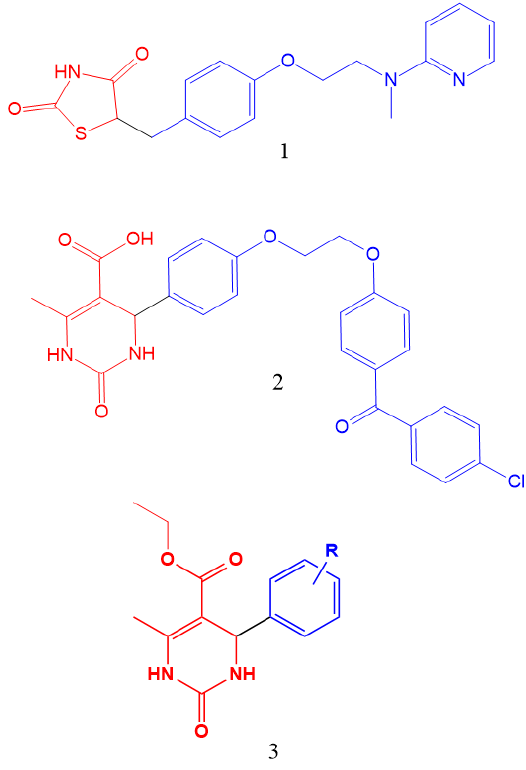
Figure 1. Generation of DHPs as PPAR- γ agonists.